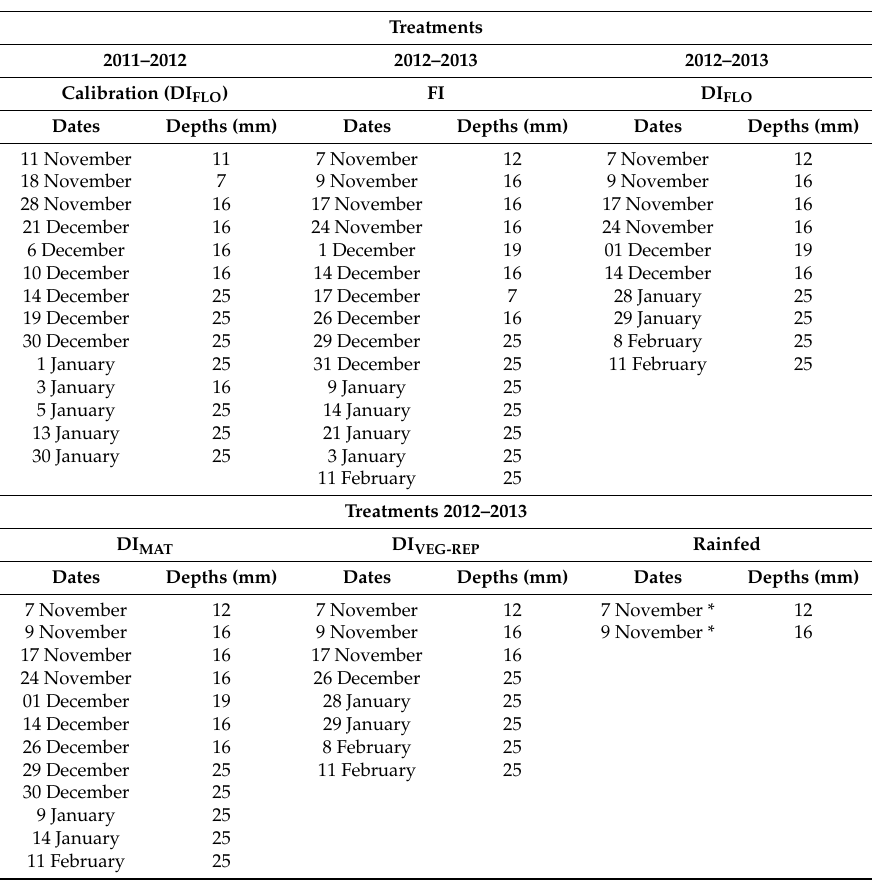
Table 2. Irrigation dates and depths for all treatments and both